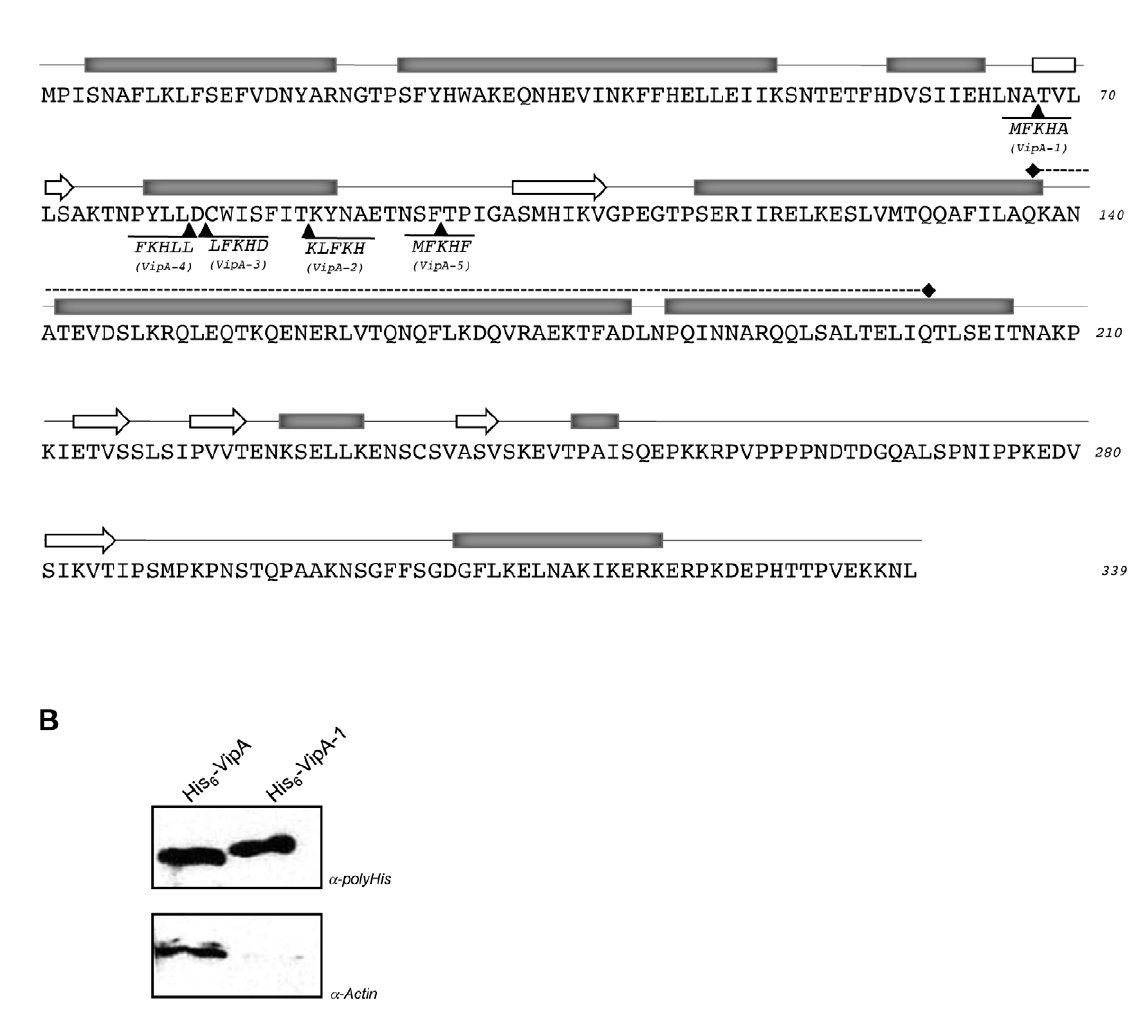
Figure 2. Vps + phenotype of VipA mutants is linked to actin binding. A. Primary sequence of VipA and localization of in-frame insertions in mutant proteins encoded by the 5 obtained Vps + alleles ( vipA-1 to vipA-5 ). The inserted residues in each allele are shown below the sequence. The predicted secondary structure is depicted, with alpha-helices as rectangles, beta-strands as block arrows (PSIPRED v2.6 software [54] and the central coiled-coil motif as dashed line (SMART software [55,56] B. Pull-down assays with G-actin and wild-type VipA or mutant VipA-1 proteins. U937 Post- nuclear supernatants were incubated with Ni-NTA agarose beads preloaded with His 6 -VipA or His 6 -VipA-1, washed and eluted with 500 mM Imidazole. Eluates were resolved by SDS-PAGE, transferred to nitrocellulose and analyzed by Western-blot with monoclonal antibodies against polyHistidine ( a -polyHis) or against actin ( a -Actin).